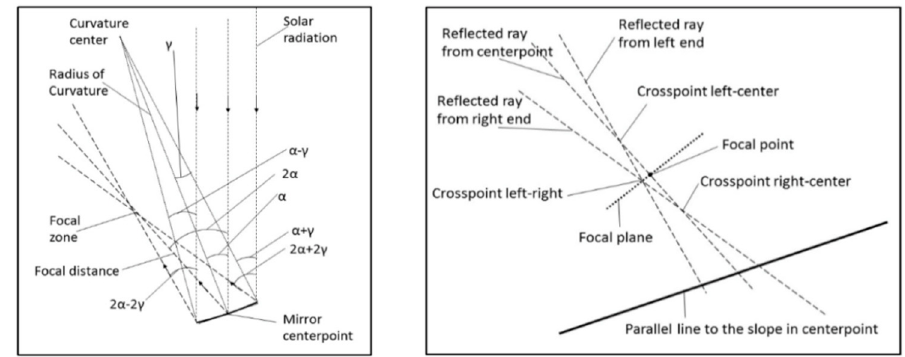
Figure 9. Scheme of the reflection.